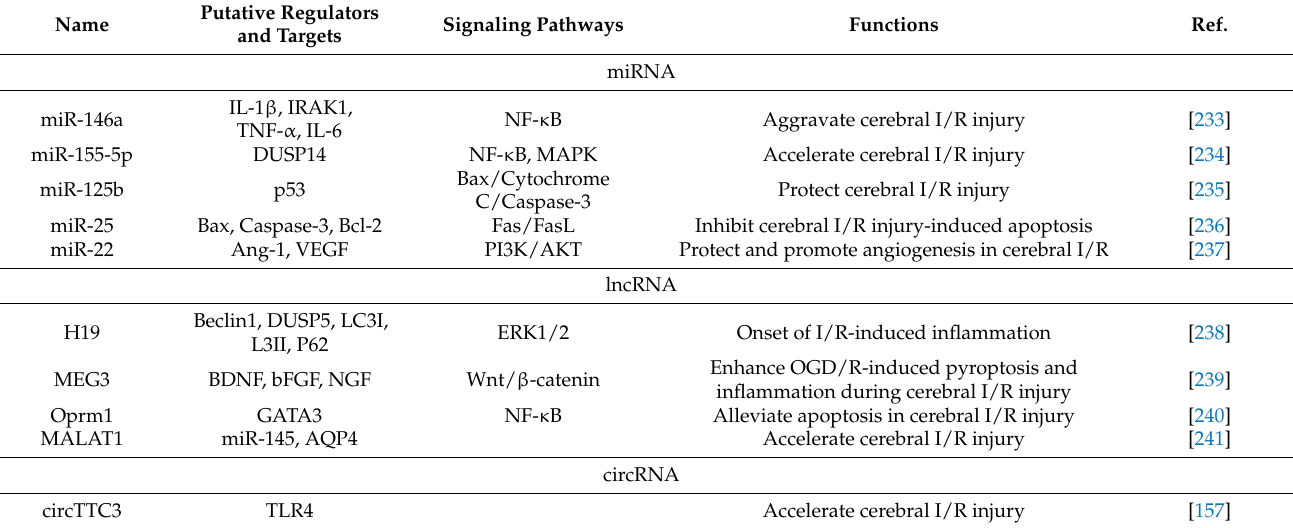
Table 5. Summary of ncRNAs involved in stroke and I/R